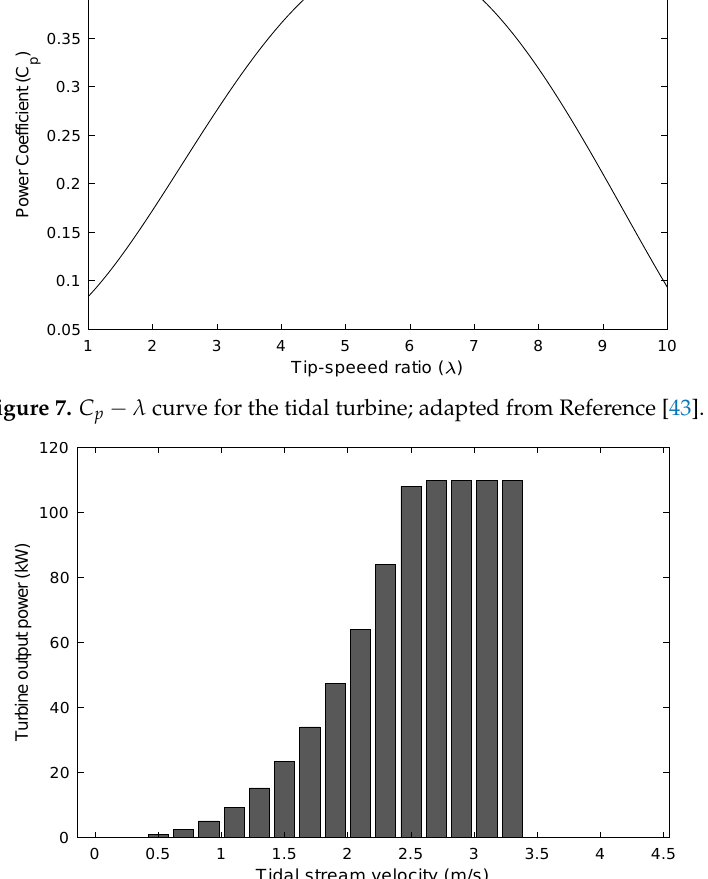
Figure 8. Power curve of the fixed pitch tidal turbine as a function of the tidal stream